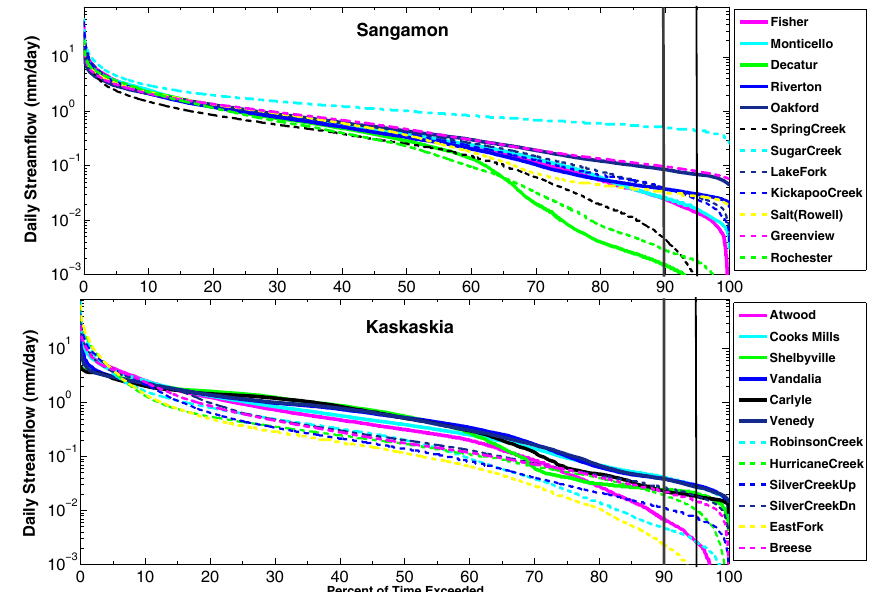
Fig. 9. Flow duration curves of both watersheds for the period 1990–2011. Note that Main-stem gauges are shown as solid lines and tributary gauges are shown as dashed